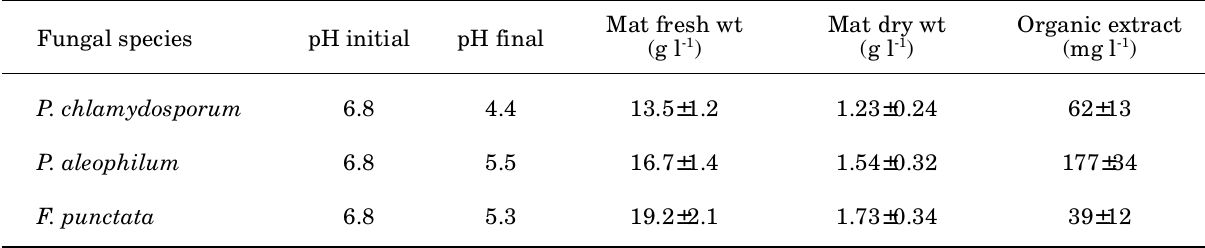
Table 1. Cultural characteristics and crude organic extract yield in liquid cultures of P. chlamydosporum, P. ale- ophilum and F. punctata a